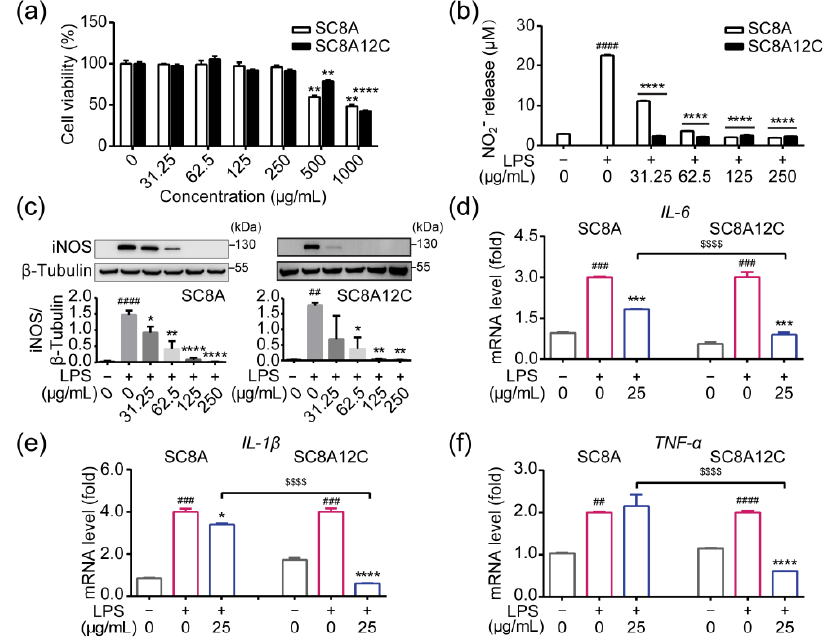
Figure 3. ( a ) Viabilities of BV2 cells treated with SC8A, SC8A12C for 24 h (** p < 0.01, **** p < 0.0001). ( b ) Measurement of NO generation by Griess assay. BV2 cells culture medium was added with LPS (0.1 μg/mL) alone, or LPS with SC8A, SC8A12C for 24 h, respectively. Cells cultured without LPS and calixarenes served as the control group. ( c ) Representative and quantitative Western blot results, in which the lanes represent the iNOS or β -tubulin level in the cell sample as shown above, illustrating that SC8A and SC8A12C significantly attenuated LPS-induced increases in iNOS expression. ( d – f ) RT-qPCR analysis proving the inhibitory effect of SC8A, SC8A12C on the transcription of LPS-induced proinflammatory genes in BV2 cells. ## p < 0.01, ### p < 0.001, #### p < 0.0001 vs. the control group; * p < 0.05, ** p < 0.01, *** p < 0.001, **** p < 0.0001 vs. the LPS group; $$$$ p < 0.0001 vs. the SC8A group.